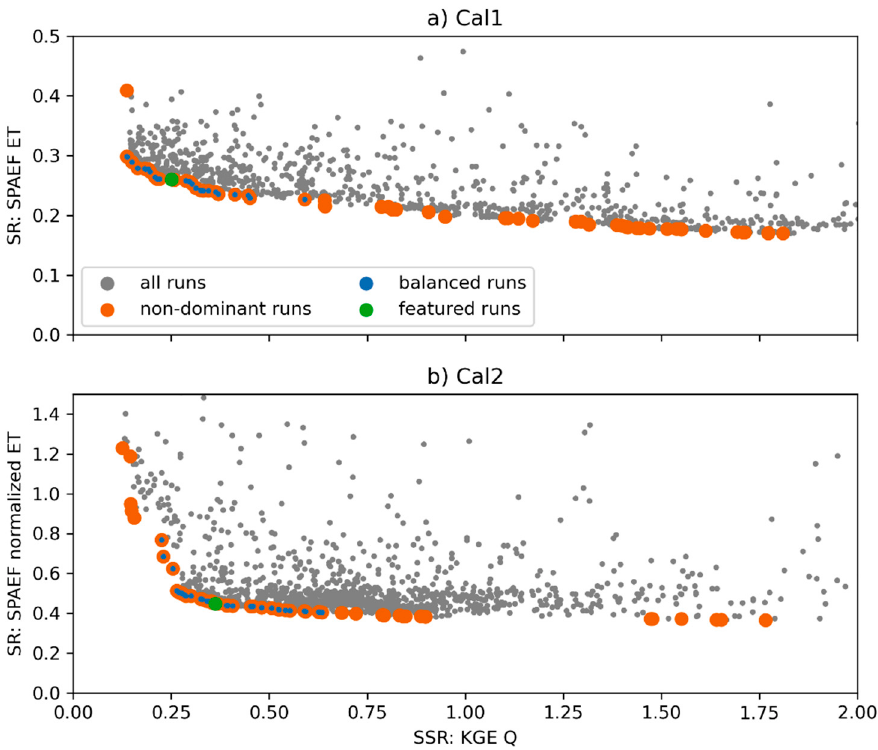
Figure 6. Calibration results for Cal1 (panel ( a )) and Cal2 (panel ( b )). Each multi-objective calibration features 2000 runs (gray) of which the non-dominated runs (orange) were identified. The balanced runs (blue) represent an ensemble that is located around the pareto optimum. A single featured run (green) for both calibrations was selected to present simulation results. Table 2. Summary of the calibration results taking only the balanced runs into consideration. The number of runs that are contained in the ensemble varies between the two calibrations and median and standard deviation (std) of the ensembles are presented. The three components of the SPAEF are stated: Correlation (r), variability ( α ) and distribution ( β ).